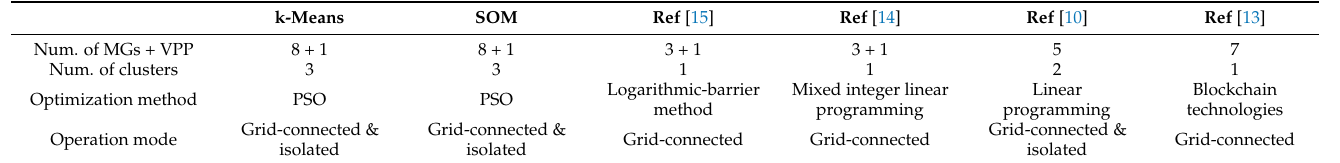
Table 4. Energy management comparison.